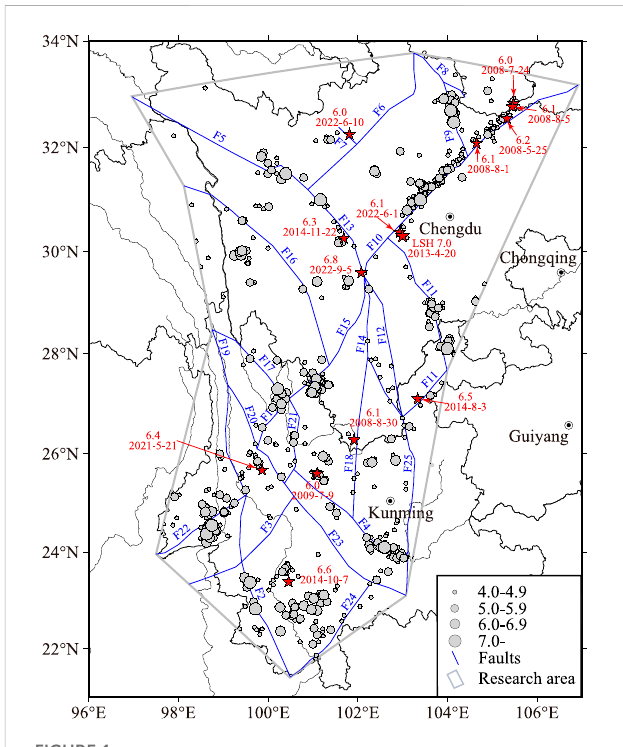
FIGURE 1 Epicenters of the earthquakes in the research area in the Sichuan- Yunnan region, China. The circle sizes represent the earthquake magnitudes. The redstars indicate thetarget earthquakes. The blue lines show the faults in the fault-model database. The gray line encloses the test area in the Sichuan-Yunnan region. Fault numbers F1 – F25 indicate the Lijiang-Xiaojinhe, Hanmuba-Heihe-Mengzhe, Nandinghe, Chuxiong-Jianshui, Ganzi-Yushu, Longriba, Songgang, Tazang, Huya, Longmenshan, Mabian, Daliangshan, Xianshuihe, Anninghe, Jinpingshan, Litang, Deqin-Zhongdian-Daju,